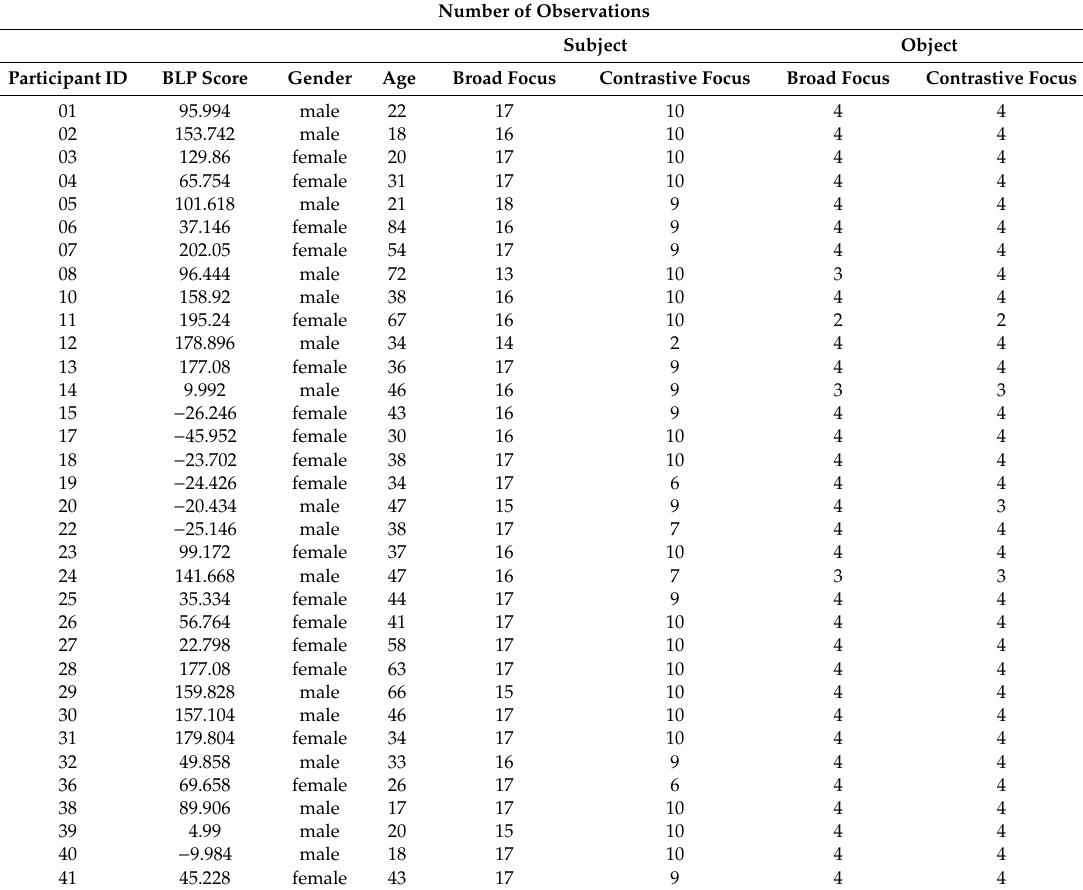
Table A1. Participants’ Bilingual Language Profile scores (BLP scores), gender, age, and number of observations (both for subject and object positions). BLP scores quantify language dominance; each end of the score corresponds to the highest dominance for Maya ( − 218) and Spanish ( + 218), respectively. Values around 0 indicate balanced